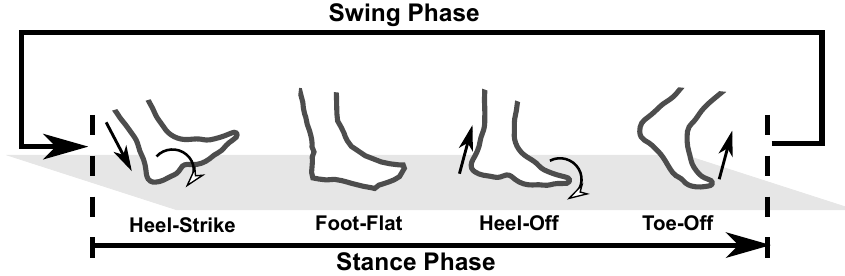
Figure 4. Detectable foot gait events and